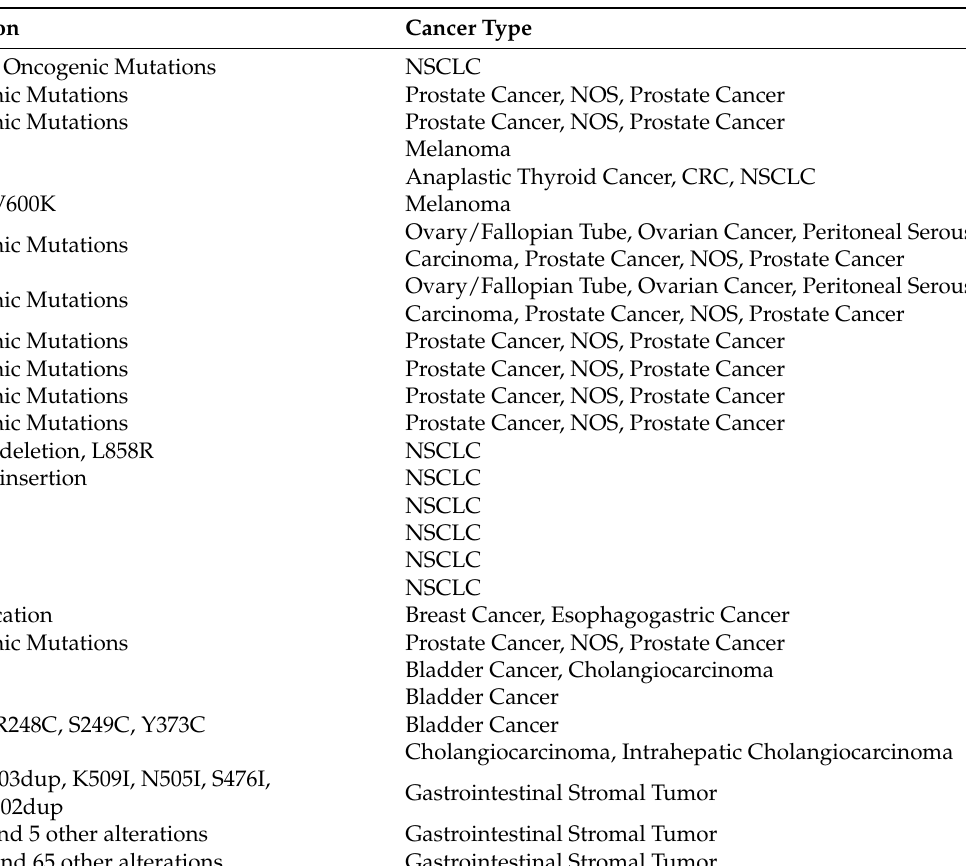
Table 1. Druggable targets in solid neoplasms modified according to